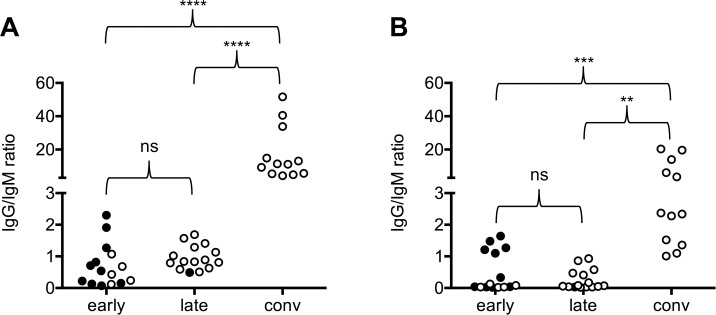
Analysis of paired CCHF patient samples: IgG/IgM ratio.Ratios of OD450 – OD620 values obtained with the BLACKBOX CCHFV IgG/IgM ELISA (A) and the VectoCrimean-CHF-IgG/IgM ELISA (B) were calculated for the analyzed serum samples. Filled circles indicate PCR positive serum samples. Statistical testing (One-way ANOVA/Tukey’s multiple comparison test) was performed with GraphPad Prism (ns: not significant (p > 0.05); **: p < 0.01; ***: p < 0.001; ****: p < 0.0001).